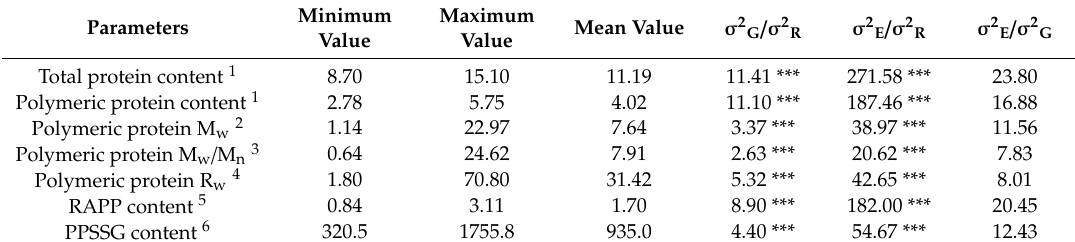
Table 2. Genetic (G) and Environmental (E) Influence on Polymeric Protein contents determined by ANOVA ( F -test) for 130 French common wheat genotypes cultivated in three di ff erent locations for 2